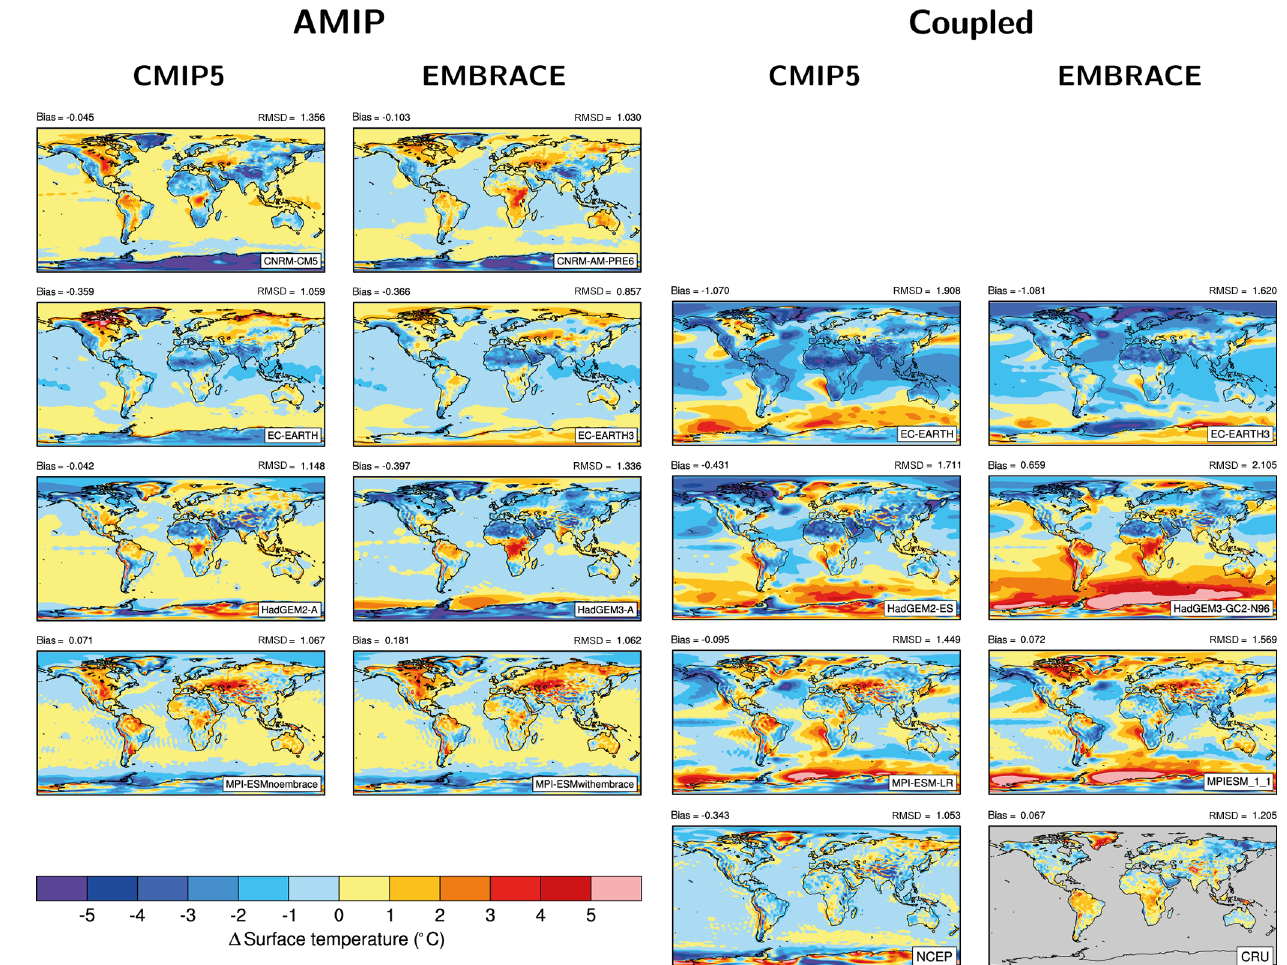
Figure 1. Bias in 20-year annual mean near-surface air temperature for the period 1986–2005 (MPI AMIP models: 1980–1999). Shown are the differences between the 20-year climatology from ERA-Interim and the following from left to right: (1) the AMIP simulations from the CMIP5 models, (2) the corresponding EMBRACE models, (3) the coupled historical simulations from the CMIP5 models, and (4) the corresponding EMBRACE models. As alternative reference datasets, data from the NCEP 1 reanalysis and the CRU dataset are shown in the two lowest rightmost panels. The global averaged annual mean bias (“bias”) and root mean square deviation (RMSD) compared with ERA-Interim are given above the individual